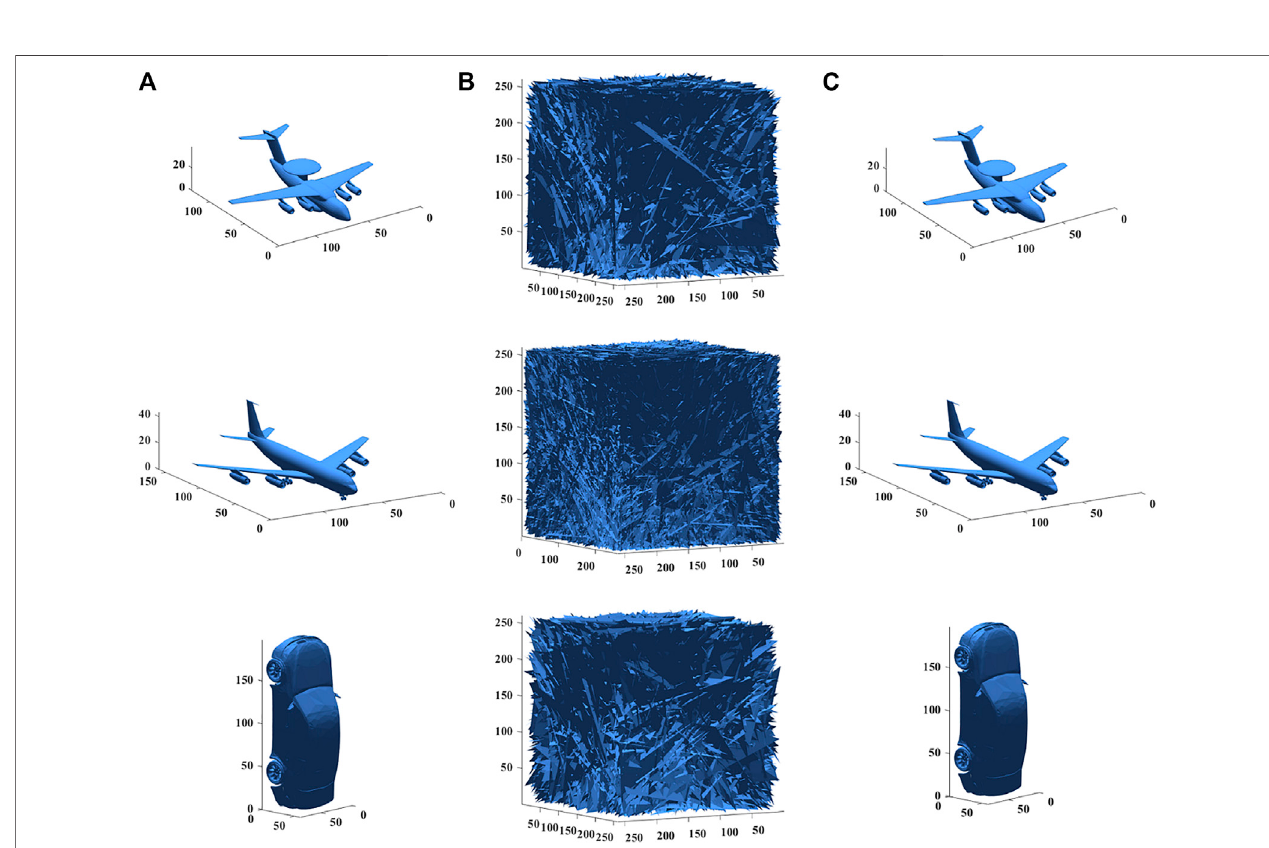
FIGURE 4 | Simulation results of 3D images (A) Plain images (Air picket, Boeing 747, BMW car) (B) Cipher images (C) Decrypted images.